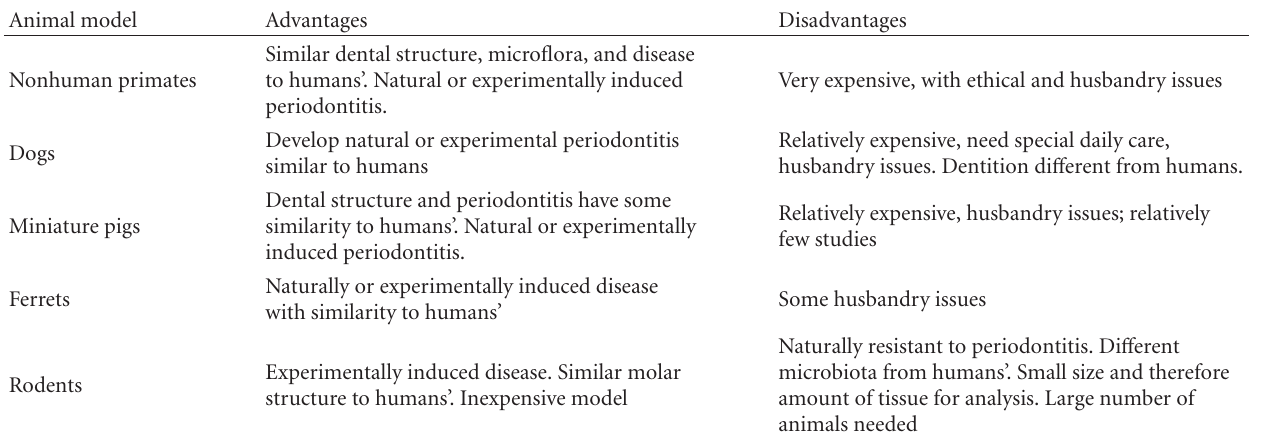
Table 1: Advantages and disadvantages of select animal models for studying periodontal disease